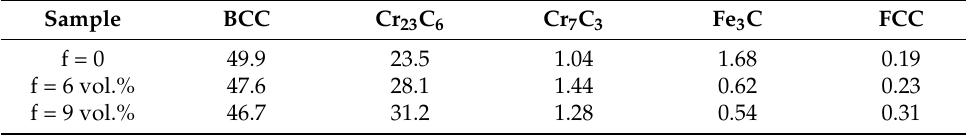
Table 3. Phase content of different